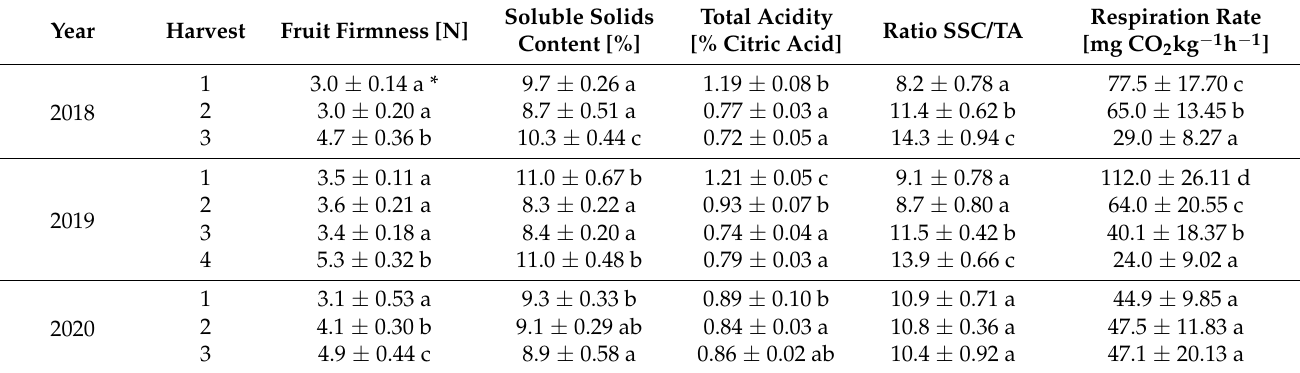
Table 2. Fruit quality of ‘Albion’ strawberry directly after harvest.